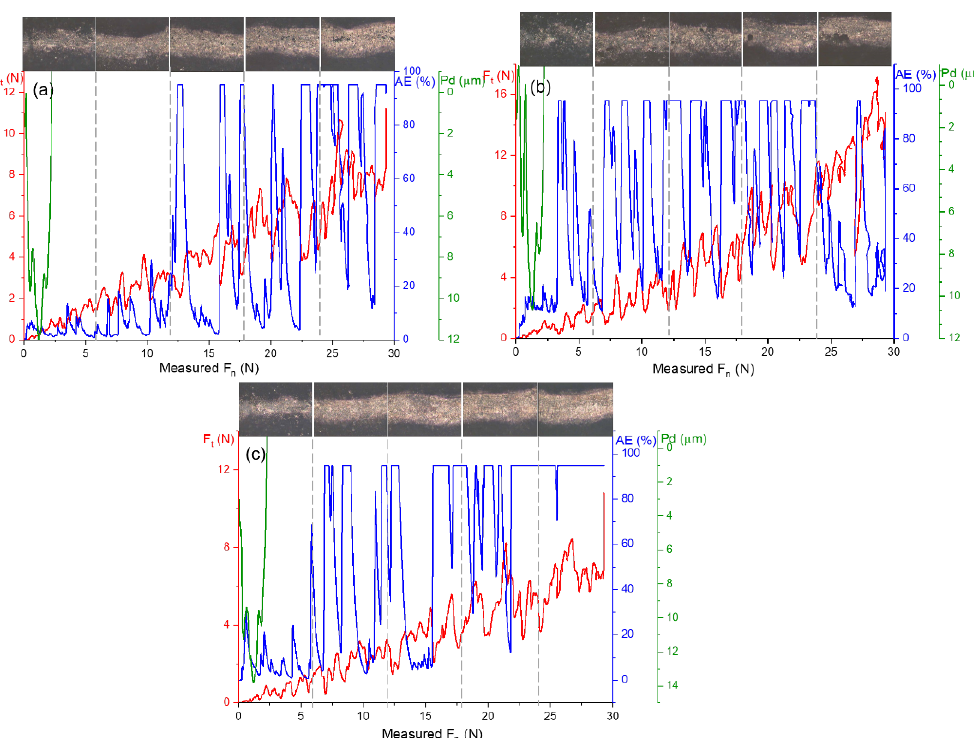
Figure 9. Stretch testing results of coatings: ( a ) TiN(1); ( b ) TiN(2); ( c )TiN(3).